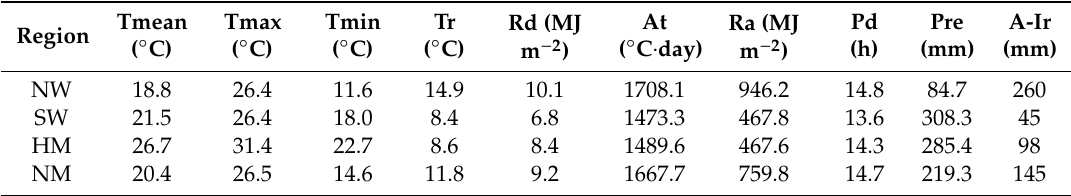
mean daily minimum temperature; Tr, diurnal temperature range; Rd: mean daily solar radiation; At: ≥ 10 ◦ C accumulated temperature; Ra: accumulated solar radiation; Pd: photoperiod; Pre: accumulated precipitation; A-Ir: average irrigation